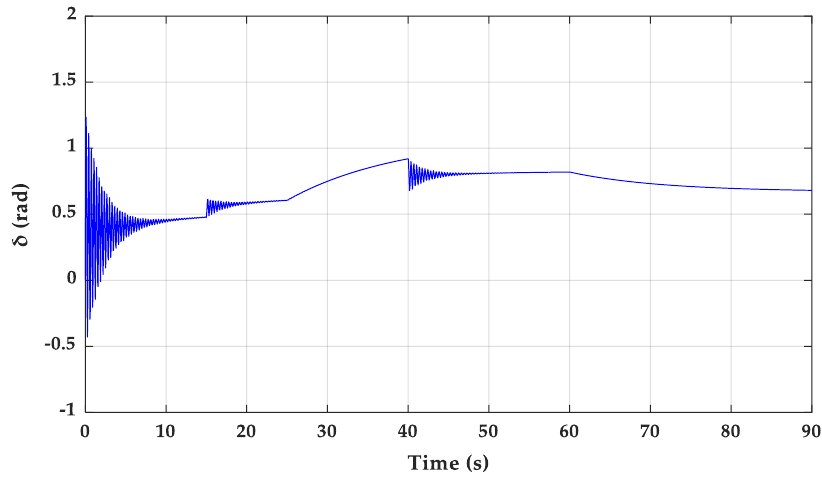
Figure 12. Angle response of the SGIB with high feedback gain.